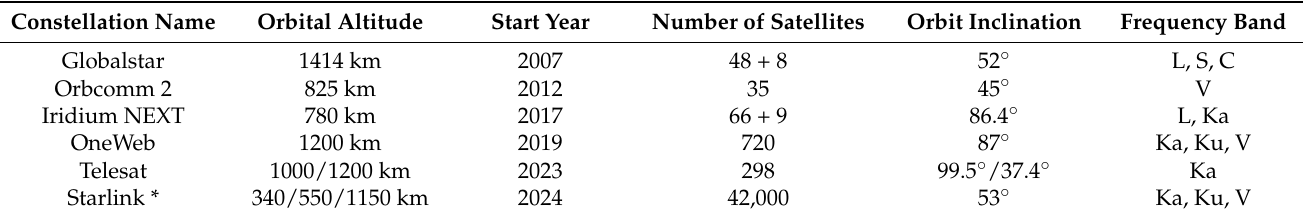
Table 1. Parameters comparison of several typical international LEO satellite constellation